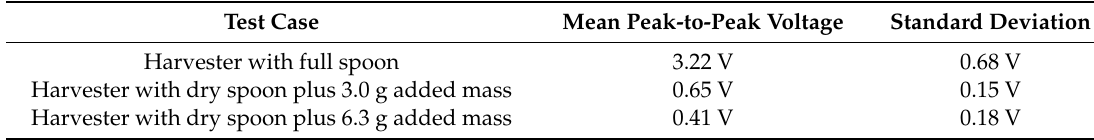
Table 1. E ff ect of rigid added mass on the open-circuit